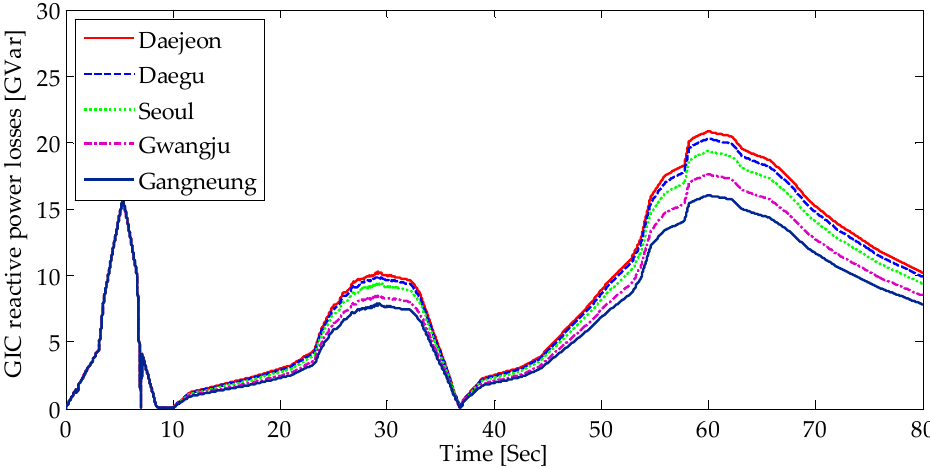
Figure 8. Time variation of the total GIC reactive power losses for E3 HEMP events over different target locations.